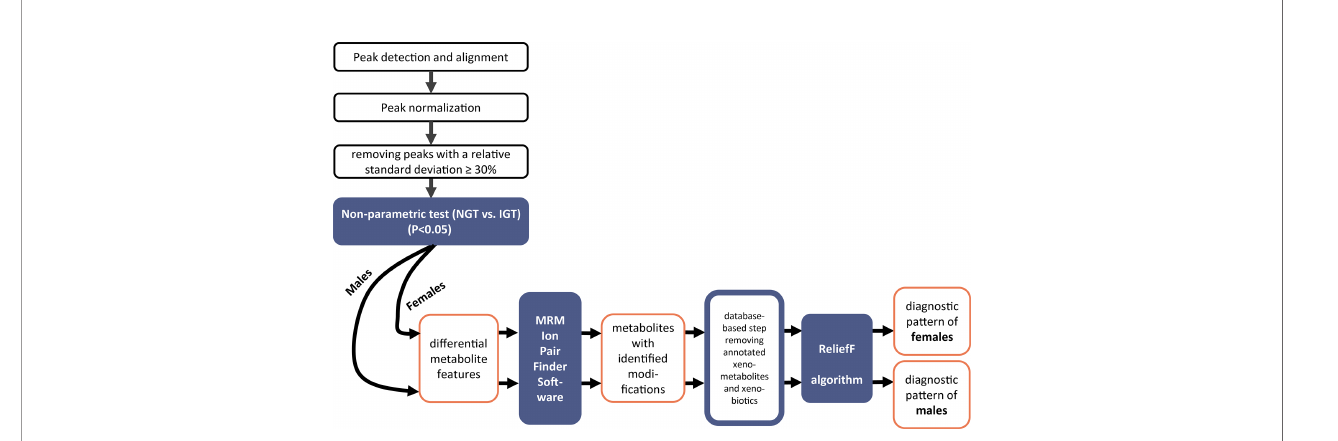
FIGURE 2 | Work fl ow of the mass spectrometric data analysis to elucidate patterns of modi fi ed metabolites for prediabetes screening in second morning